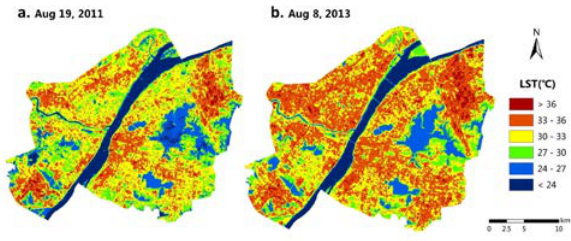
Figure 2. LST retrieved from ETM+ imagery for August, 2011 and